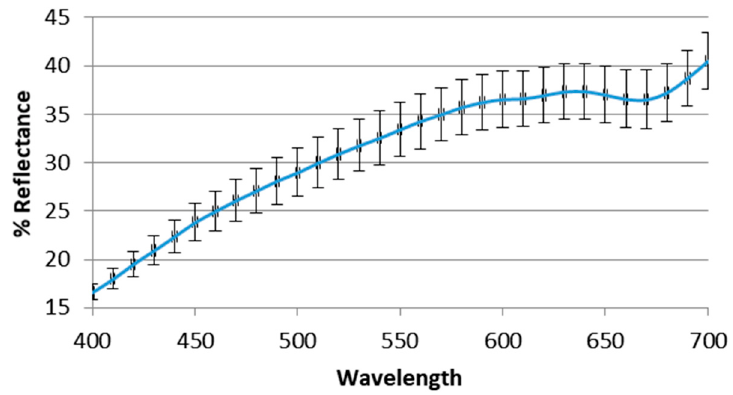
Figure 2. Reflectance graph of A. mollis aerial parts.